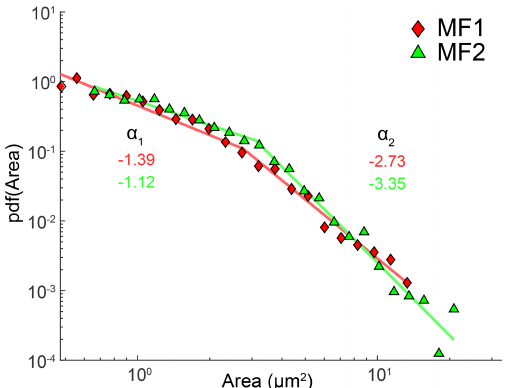
Figure 4. Grain size distribution of plagioclase grains in MF1 and MF2. A probability density function (pdf) was fitted to each distribution. The distributions display two different power law slopes (a) for the small and large grains. See Aupart et al. (2018) for details on the fitting